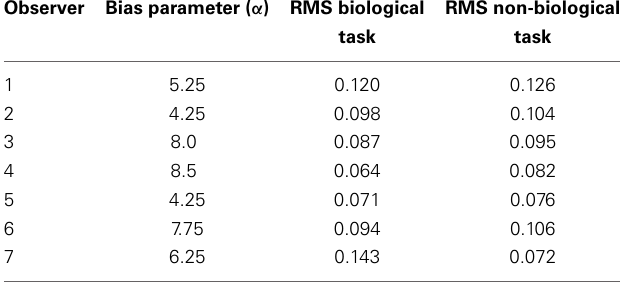
Table 2 | Overview of the fitted bias parameter and root mean squared errors (RMS) fit between human and model data for each of 7